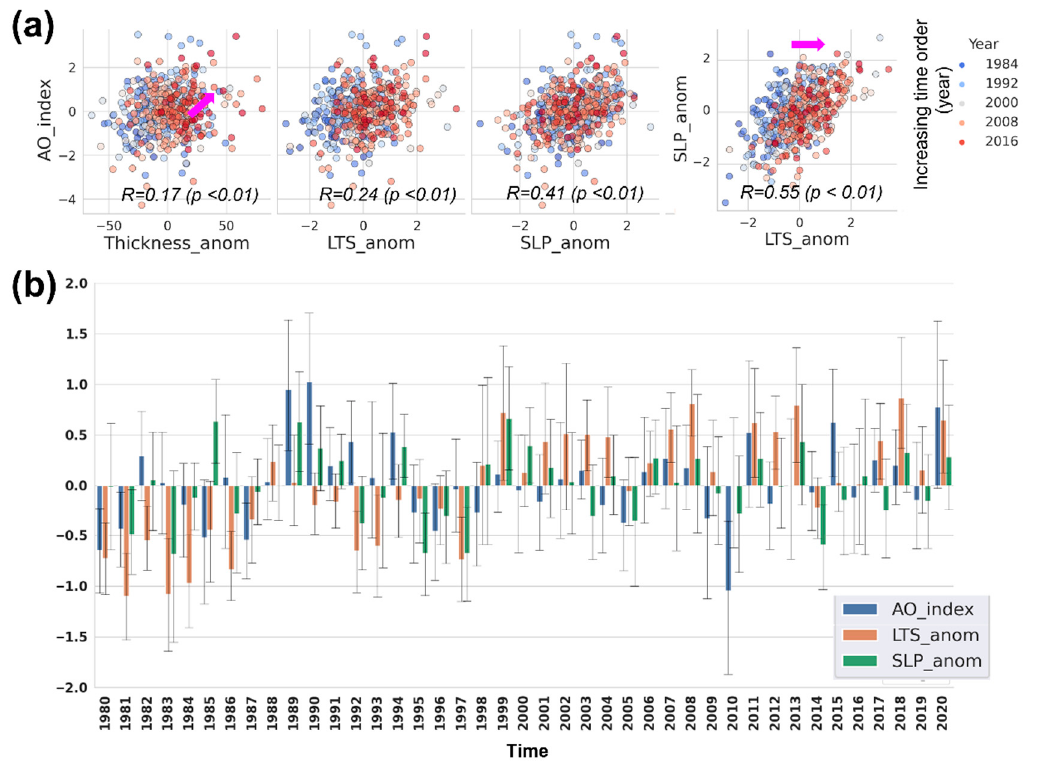
Figure 9. ( a ) (from left to right ) Scatter plots of the AO index with the thickness (geopotential height from 500 to 1000 hPa) anomaly, low-level tropospheric stability (LTS; potential temperature difference between 700 hPa and 1000 hPa) anomaly, and SLP anomaly. Scatter plot of the SLP anomaly with the LTS anomaly. The SLP anomaly is normalized by subtracting the climatological mean from each value and dividing by the standard deviation. The colors of circle markers in ( a ) represent the monthly anomalies of the variables for each year (1980–2020) in increasing time order (from blue to red). ( b ) Time series of the annual mean of AO, LTS anomaly, and SLP anomaly over the eastern Pacific and western U.S. (160–100° W and 30–50° N) from 1980 to 2020. The error bars represent the 95% confidence intervals around the values computed by 5000 bootstrap iterations. The R-value in ( a ) represents the Pearson correlation coefficient at a 99% confidence level. The magenta arrow in ( a ) represents the shifted pattern over time.